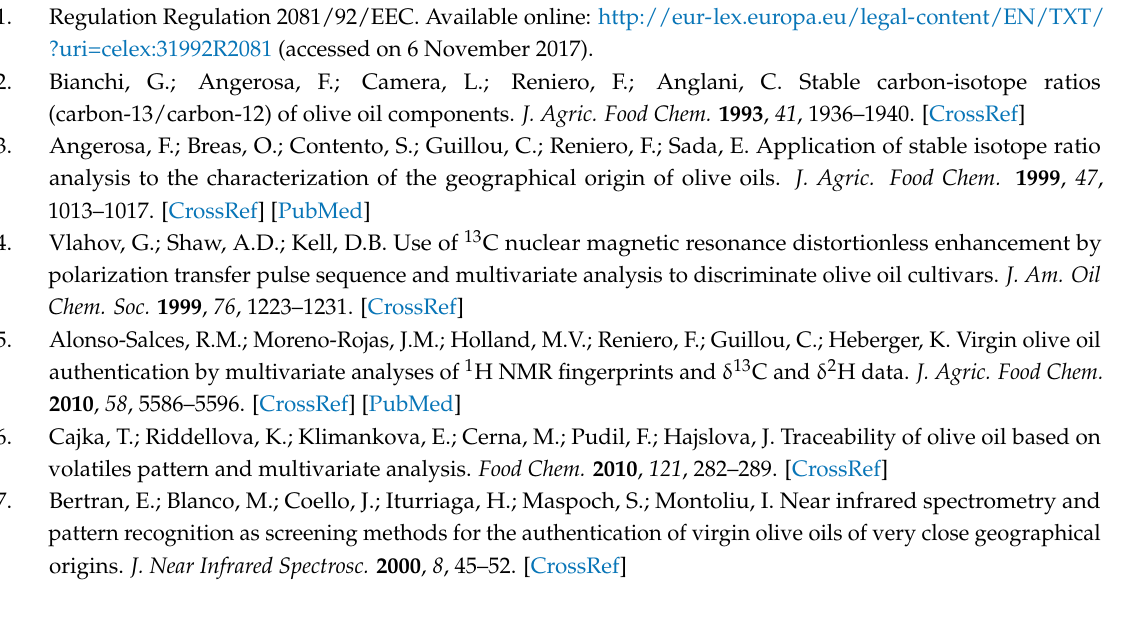
Table S1: Fatty acid composition data calculated on the basis of 1 H NMR, expressed in molar percentage. Table S2: One-Way